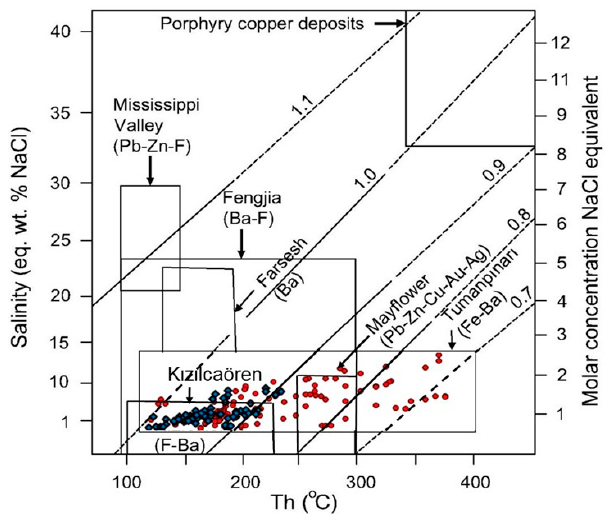
Figure 9. Homogenization temperature (Th) versus salinity for primary fluid inclusions contained in quartz and barite. Diagonal grid lines show fluid densities in gm/cm 3 from the system NaCl-H 2 O [29] Data from porphyry copper deposits, Mississippi Valey, Fengjia, Farsesh, Mayflower and K ı z ı lcaören are from [30–35]. The inclusions in Tumanp ı nar ı quartz and barite is shared by data from Fengjina, Farsash and K ı z ı lcaören deposits containing Ba and F. (red point: quartz; blue point: barite).